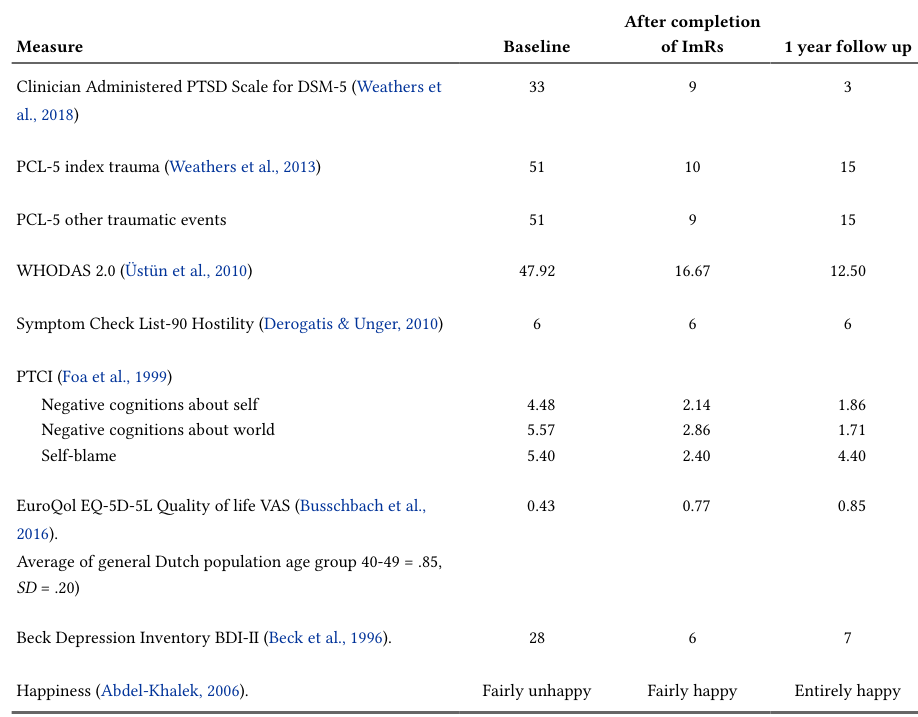
After completion of ImRs 1 year follow up